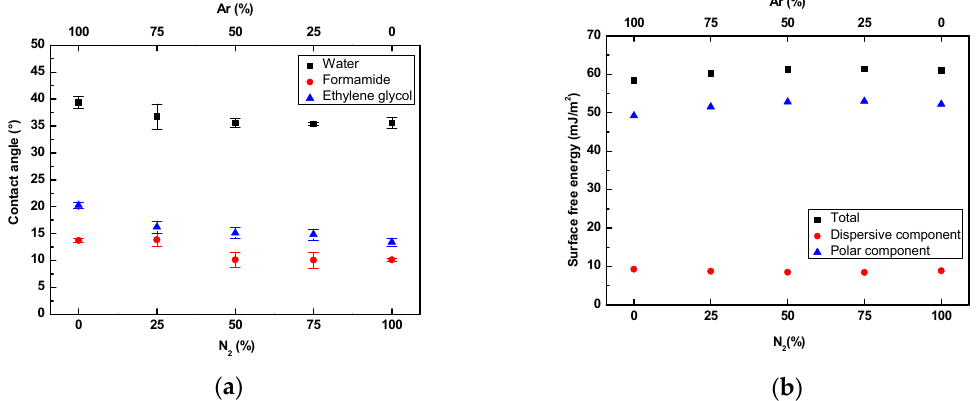
Figure 5. ( a ) Contact angle of water and ( b ) the surface free energy as a function of gas concentration for PU treated using N 2 / Ar plasma for 180 s.